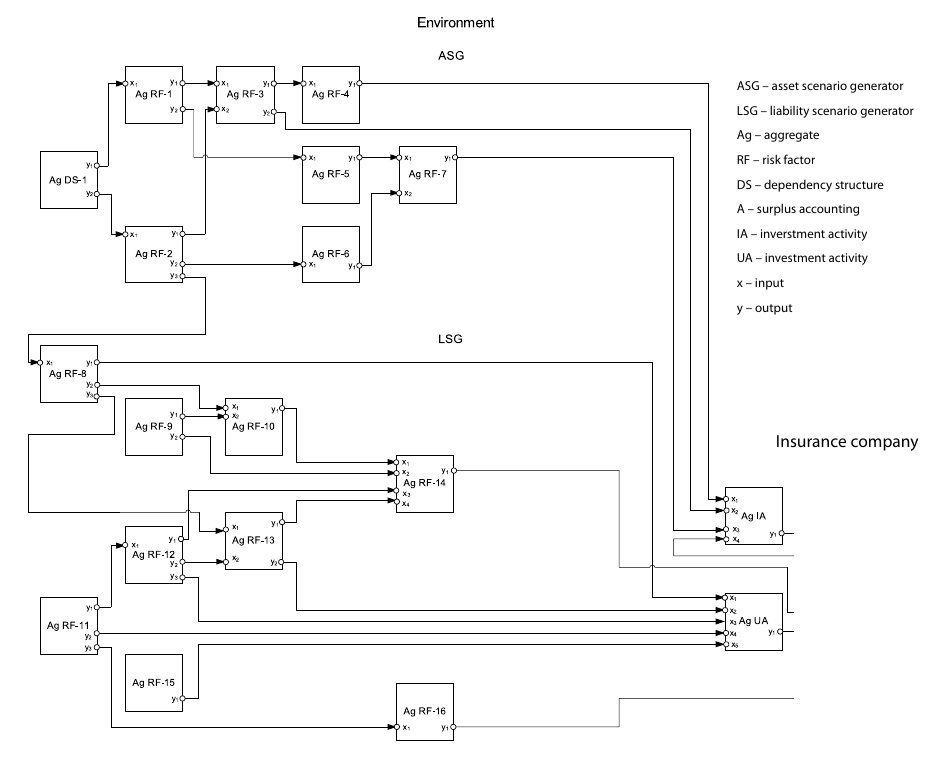
Fig. 7. Aggregate scheme for the decision-making model in insurance